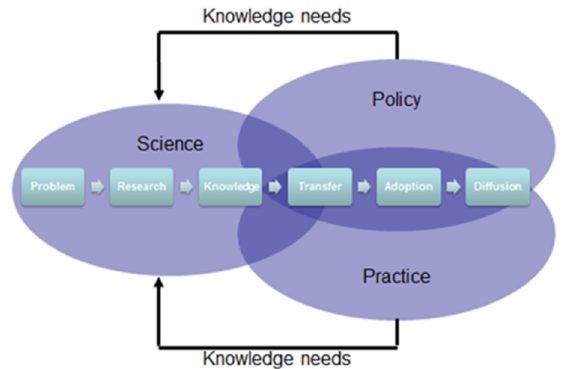
Figure 1. The science-policy-practice continuum (adapted from [10]).